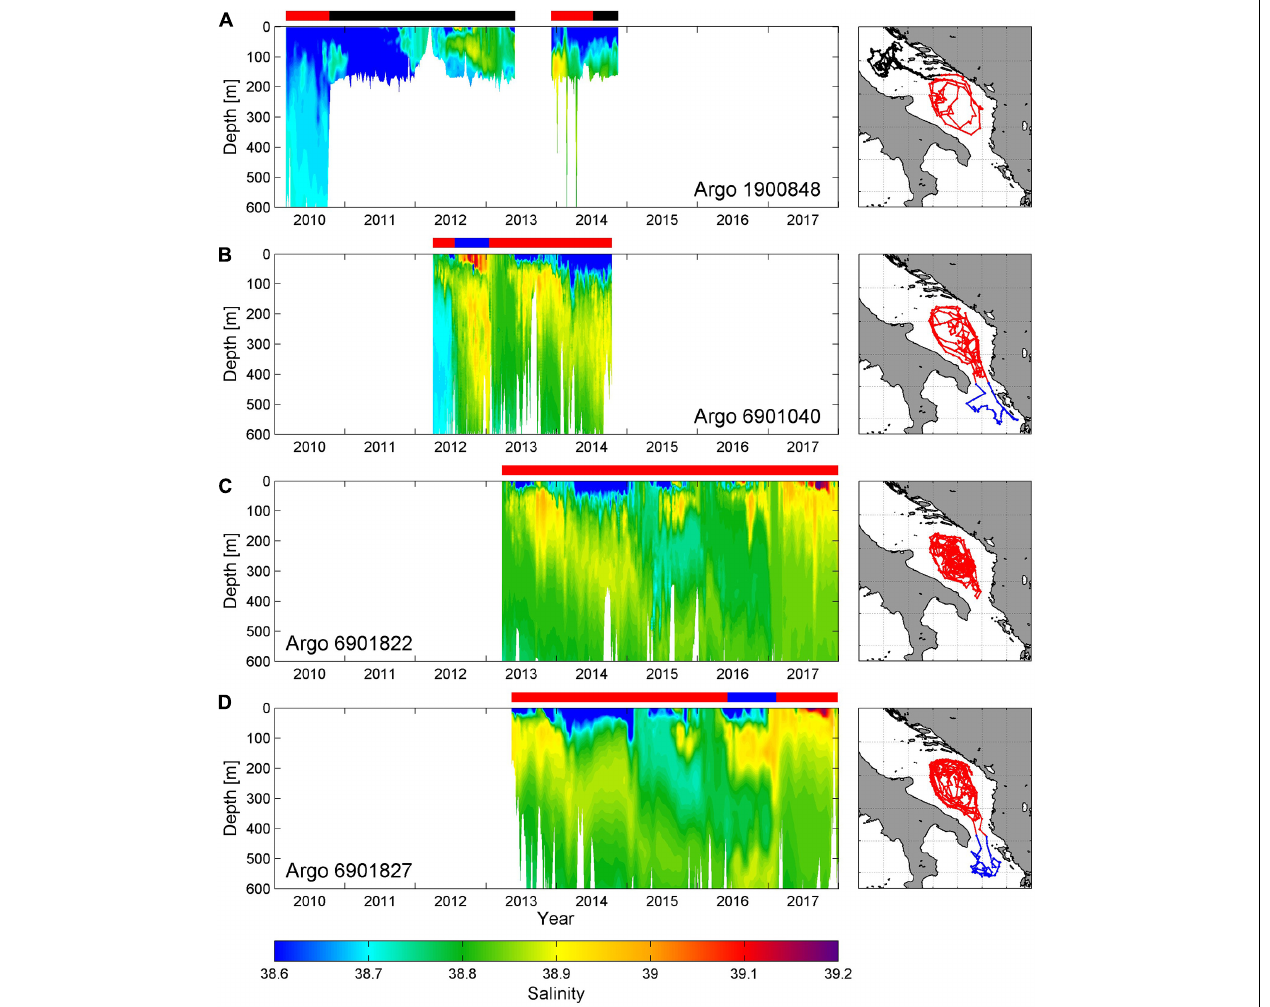
FIGURE 7 | (A) Hovmöller diagram of salinity data for Argo float 1900848 in the first 600 m in the period 2010–2014 (left panel) with corresponding float trajectory (right panel). (B–D) As in panel (A) except for Argo floats 6901040 (2012–2014), 6901822 (2013–2017) and 6901827 (2013–2017), respectively. Argo trajectories are colored depending on the location of the float (black–Middle Adriatic, red–Southern Adriatic, blue–Northern Ionian). The same color notation is used in horizontal bars above left panels, indicating periods during which Argos were profiling in respective